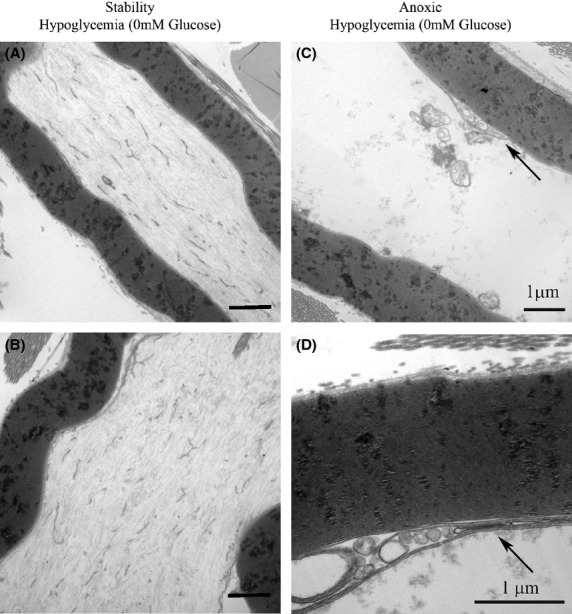
Electron micrographs of nerves that were and were not exposed to anoxia in the absence of glucose. (A, B) In the nerves not subject to anoxia, intact axons have well-defined axoplasm, cytoskeleton, and neurofilaments (a = 12,500X, b = 12,500X). (C, D) Nerves subject to anoxia in the absence of glucose demonstrate retraction of the inner loops of myelin (arrows), early axonal degeneration with loss of cytoskeleton and neurofiaments (c = 12,500X, d = 31,500X).